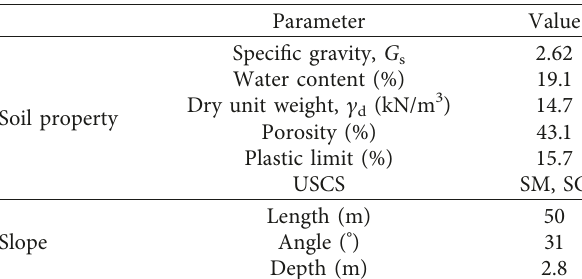
Table 1: Summary of basic soil properties and slope